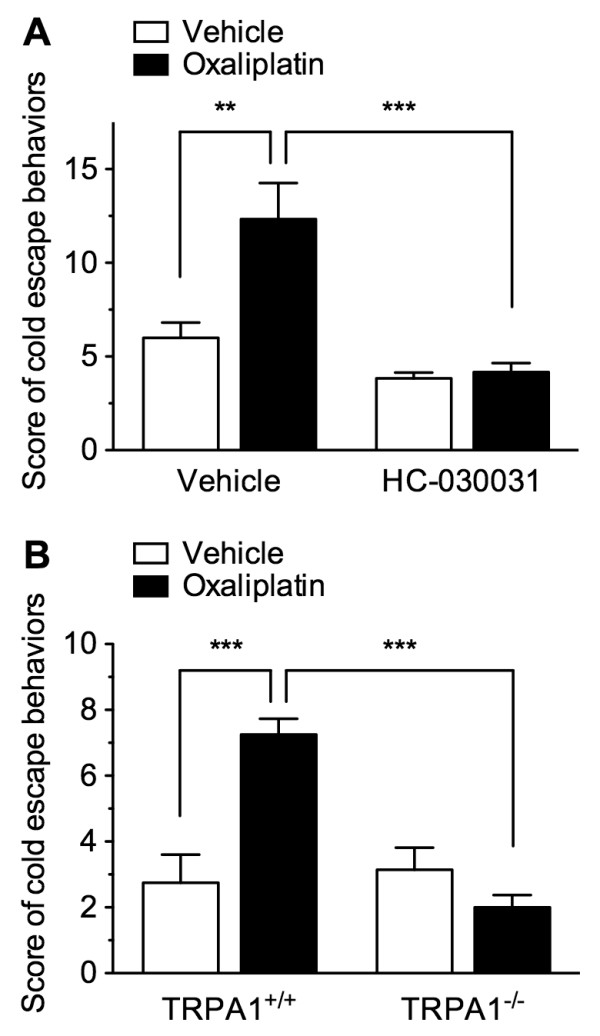
TRPA1 is involved in oxaliplatin-induced acute cold hypersensitivity. ( A) Mice were intraperitoneally administered vehicle or oxaliplatin (5 mg/kg) 2 h before the cold-plate test, with vehicle or HC-030031 (100 mg/kg) intraperitoneally injected 30 min before testing. n = 6. ( B) TRPA1+/+ or TRPA1−/− mice were intraperitoneally administered vehicle or oxaliplatin (5 mg/kg) 2 h before the cold-plate test. n = 7–8. Escape behaviors in response to cold stimulation (5°C) were scored in a cold-plate test. Data are presented as the mean ± S.E.M. ** p < 0.01, *** p < 0.001.